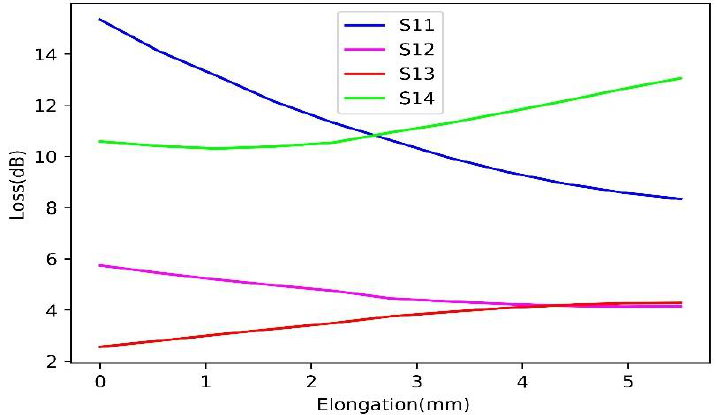
Figure 3. S parameter response to changes in